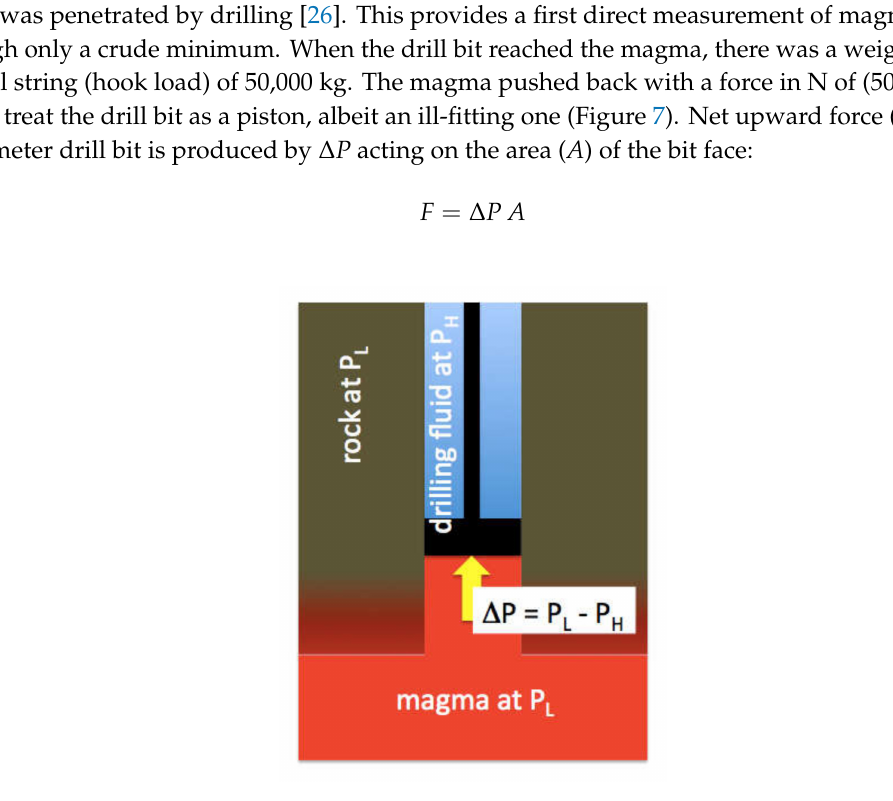
Figure 7. The di ff erence between magma pressure beneath the drill bit and fluid pressure above it supports some of the weight of the drill